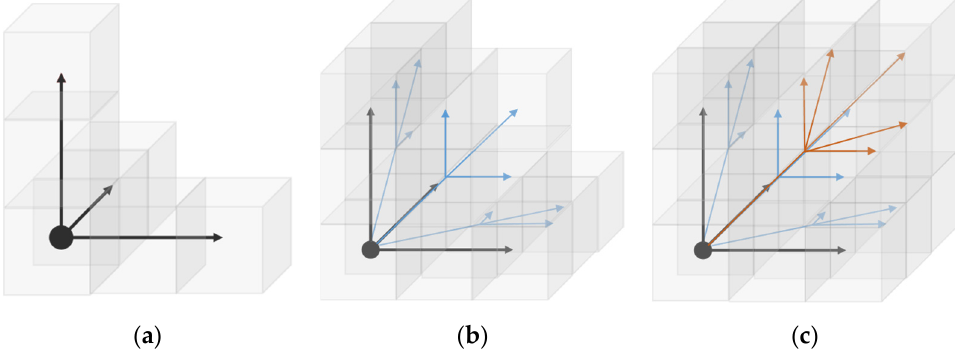
Figure 8. Three ‐ dimensional JPS algorithm extension method. ( a ) Same ‐ plane linear extension. ( b ) Figure 8. Three-dimensional JPS algorithm extension method. ( a ) Same-plane linear extension. Same ‐ plane diagonal extension. ( c ) Body diagonal extension. ( b ) Same-plane diagonal extension. ( c ) Body diagonal